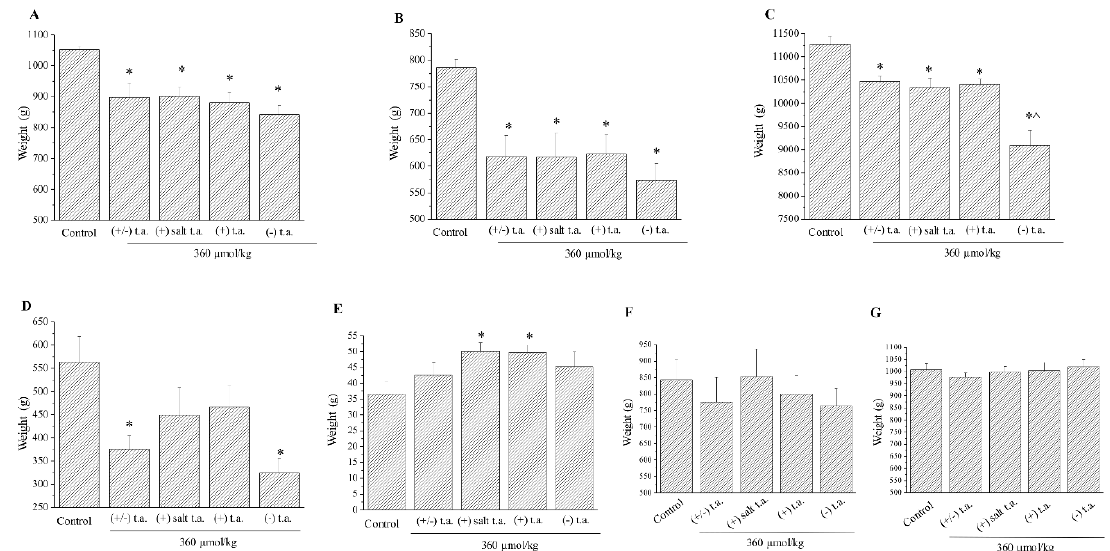
Figure 4. Subchronic toxicity treatments: organ weight. Effect of 15-day subchronic toxicity treatment with 360-µmol/kg thioctic acid (t.a.) isoforms (racemate, (+) tromethamine salt enantiomer, (+) acid enantiomer, (−) enantiomer) on: ( A ) heart, ( B ) spleen, ( C ) liver, ( D ) thymus, ( E ) adrenal gland, ( F ) right lung and ( G ) kidney. Each value represents the mean ± SEM of 6 rats per group. * p < 0.05 vs. control; ^ p < 0.05 vs racemate, (+) thioctic acid.